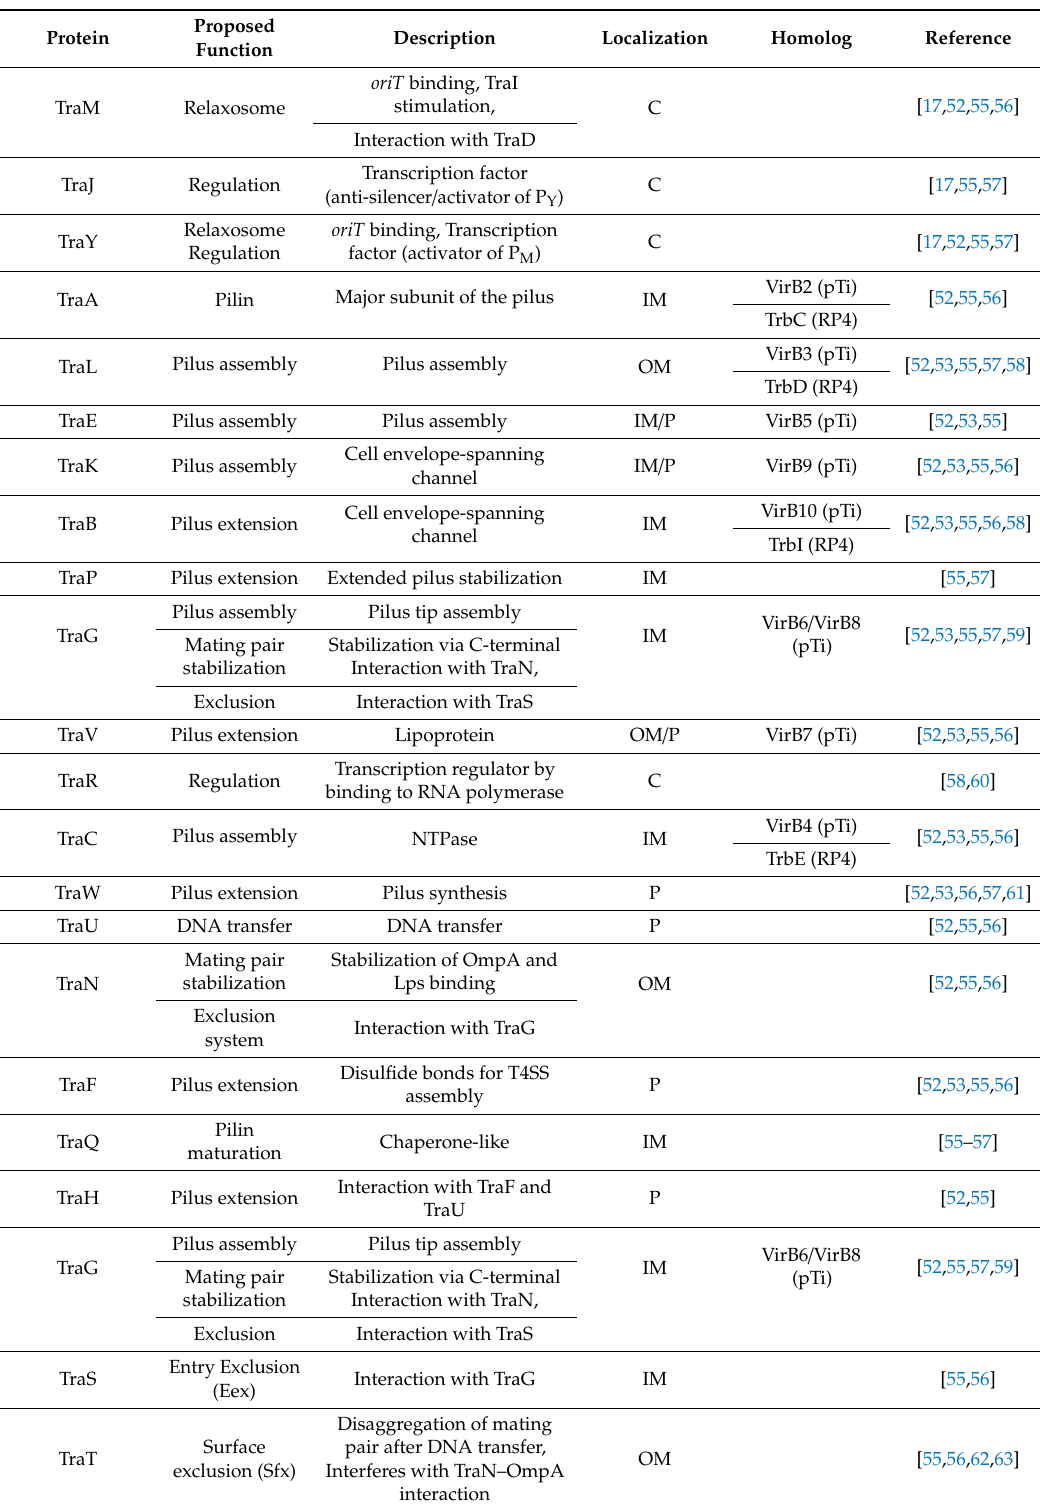
Table 1. Description of Tra proteins. Proteins are presented following the order of the corresponding tra genes in the tra region of the F plasmid. The proposed function, the description of their biological activity, the subcellular localization (IM: Inner membrane; OM: Outer membrane; C: Cytoplasm; P: Periplasm), and the homologs in RP4, pTI, or R388 plasmids are